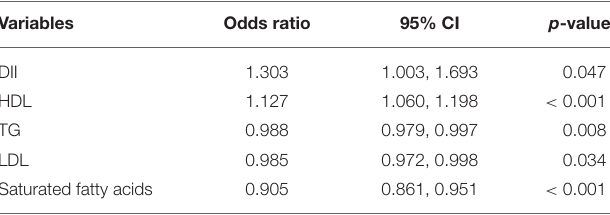
TABLE 5 | Conditional logistic regression analysis with HF status as outcome. Variables